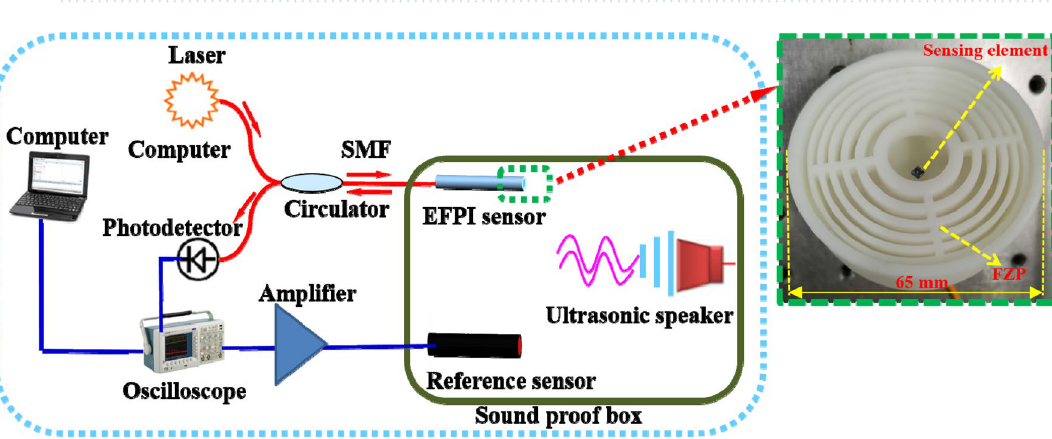
Figure 6. The experimental setup to characterize the proposed ultrasonic sensor, with the inset showing the image of the combined structure of sensing element and